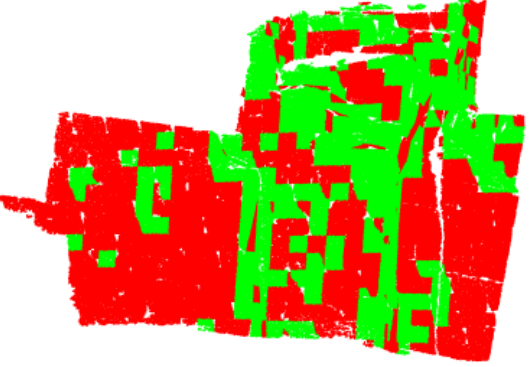
Figure 2. The distribution of non-coplanar voxels(marked in green) in the point